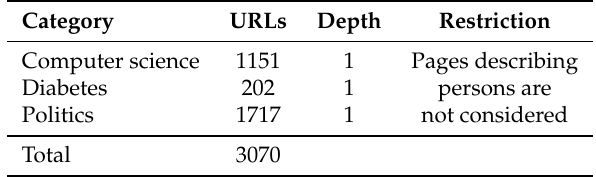
Table 2. The number of web pages extracted for the three different